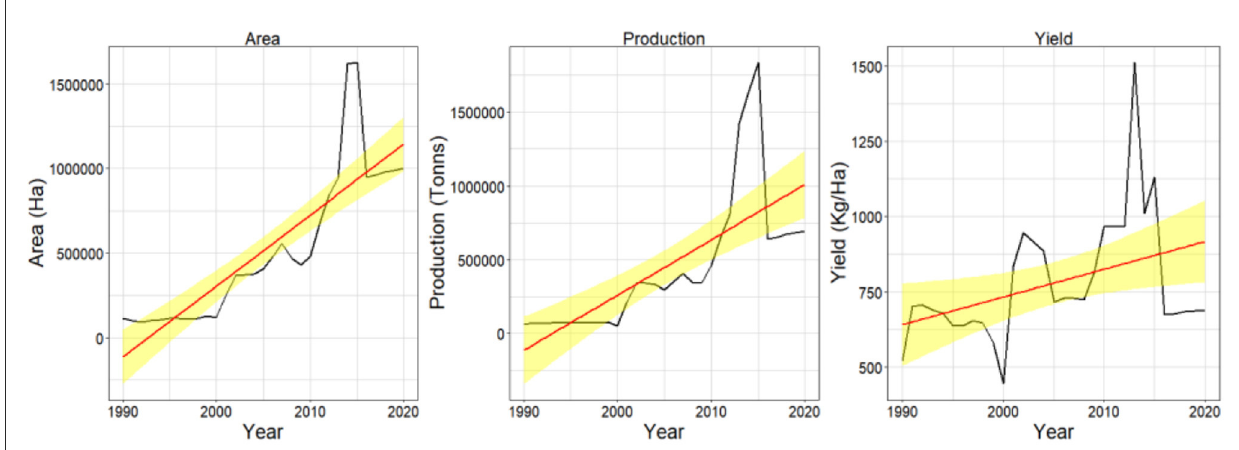
FIGURE1 Trends in the groundnut production area, production, and yield in Tanzania from 1990 to 2020.